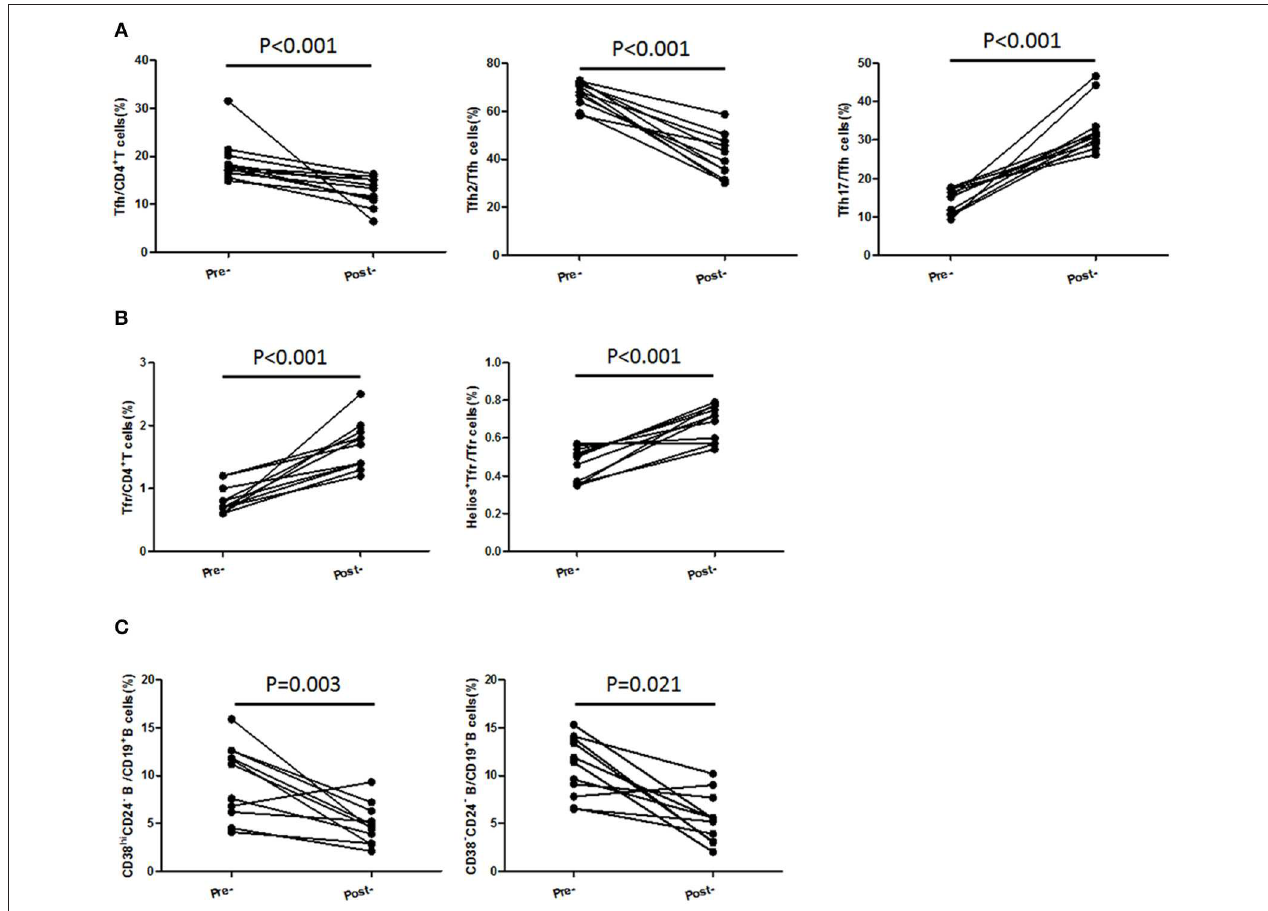
FIGURE 6 | TFH and TFR subsets were recovered in patients achieving stable remission from active stage. Peripheral blood were collected from 11 active UC patients who achieved stable remission after being treated with 5-ASA. (A,B) CD4 + CXCR5 + FoxP3 + TFR cells, CD4 + CXCR5 + FoxP3 − TFH